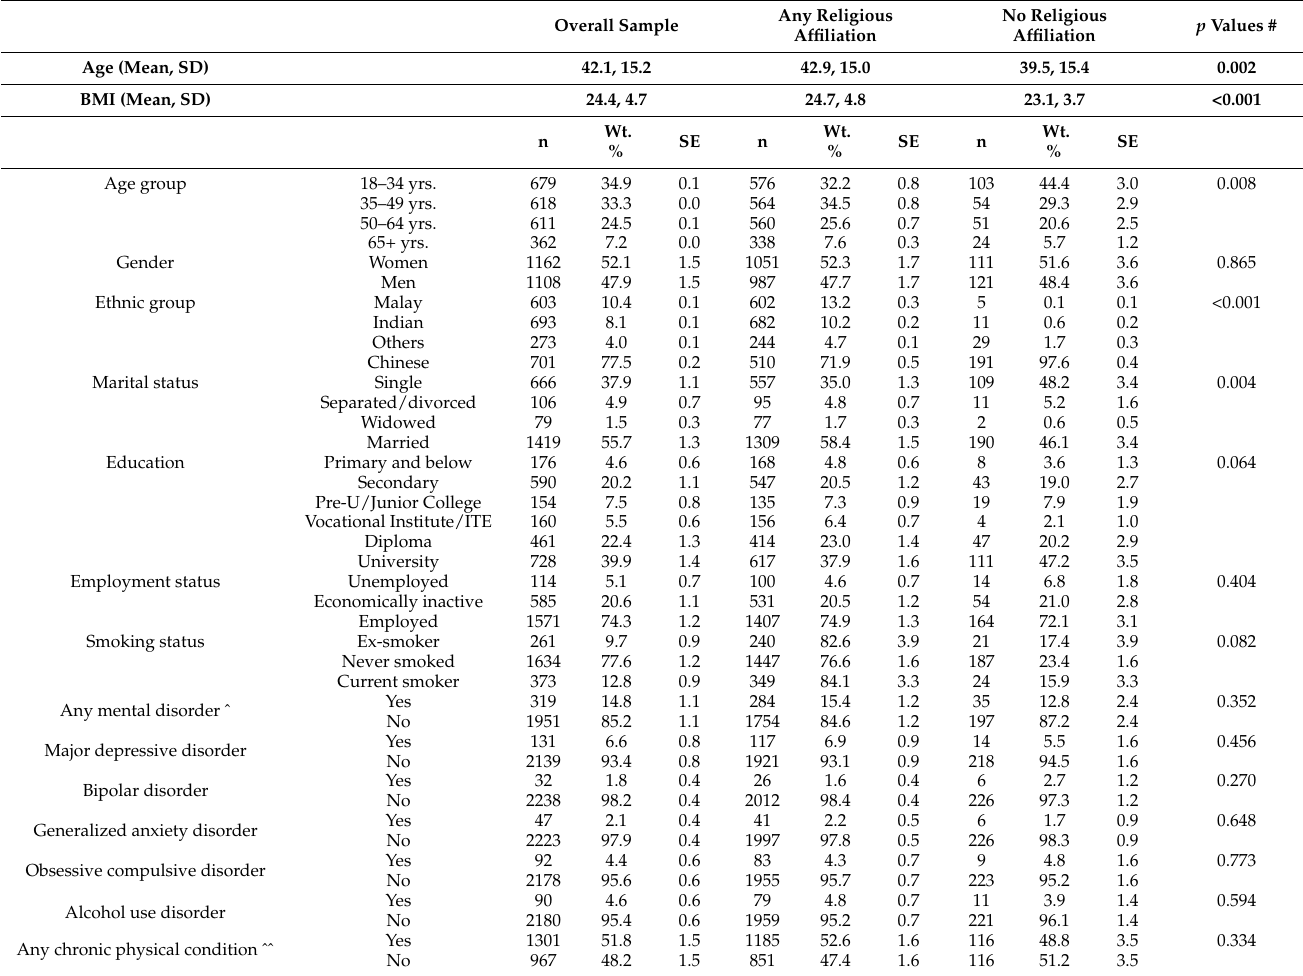
Table 1. Socio-demographic characteristics of the sample and respondents with and without any religious affiliation. Overall